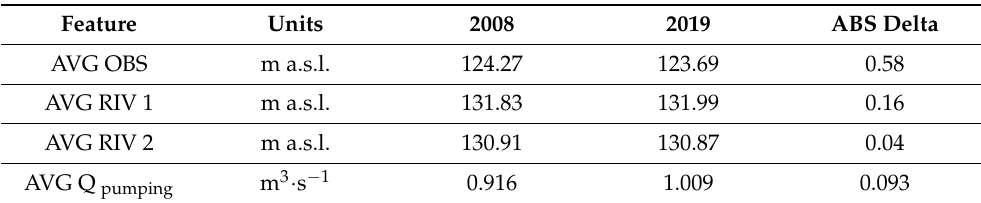
Table 1. Comparison of the values of main features influencing modeled conditions between the years 2008 and